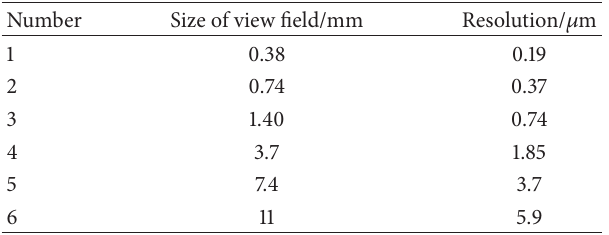
Table 1: Relationship between size of view field and